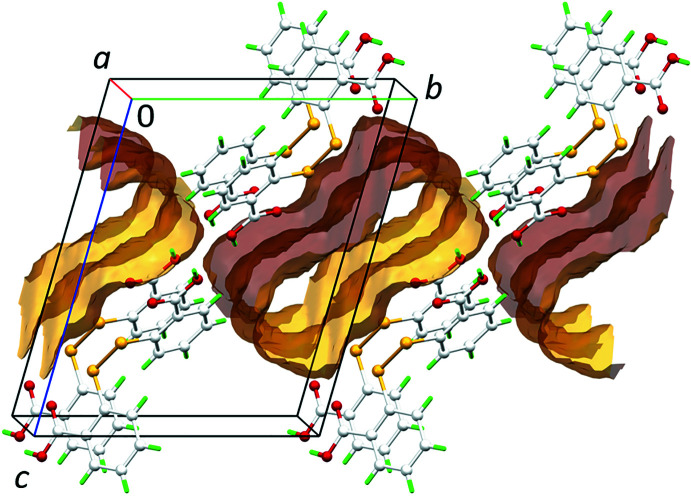
A perspective view of the solvent-accessible voids in the crystal of (I), calculated after removal of the DMF solvent mol­ecules within 2 × 2 × 1 unit-cells.